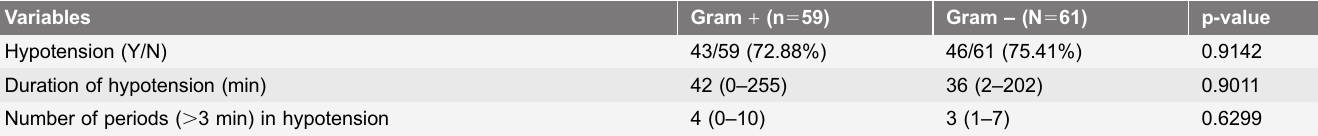
Table 2. Differences in severe hypotension on the day of positive BSI between patients with gram + and gram- infection.